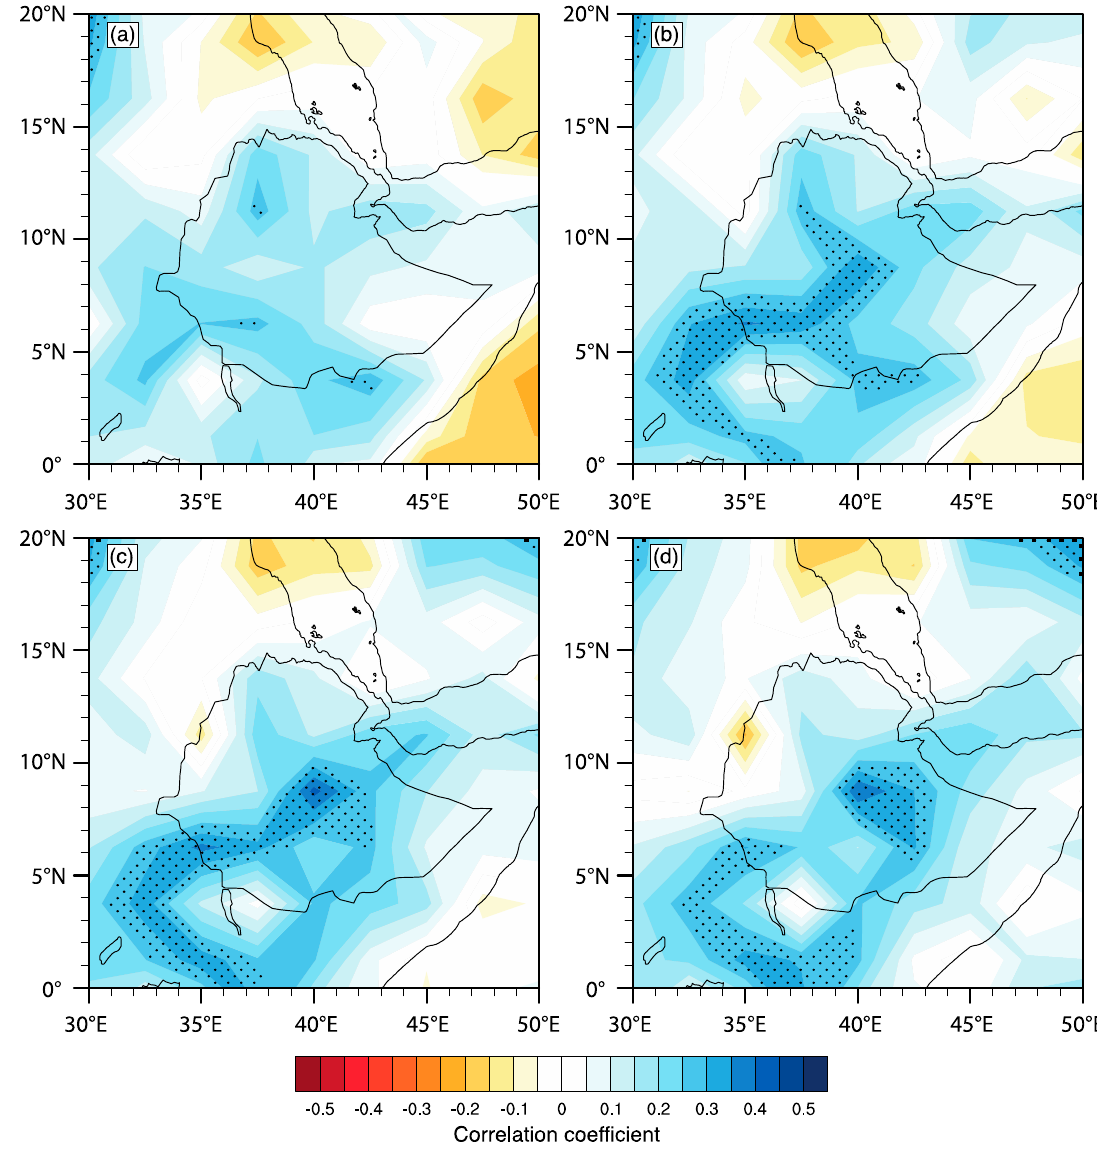
Figure 8. Comparisons of the lagged correlation between Kiremt rainfall and the new DMI NOENSO index during ( a ) March–May (MAM), ( b ) April–May (AMJ), ( c ) May–July (MJJ), and ( d ) June–August (JJA). Dotted points indicate statistically significant grid points at the 95% confidence level (one-tailed test).